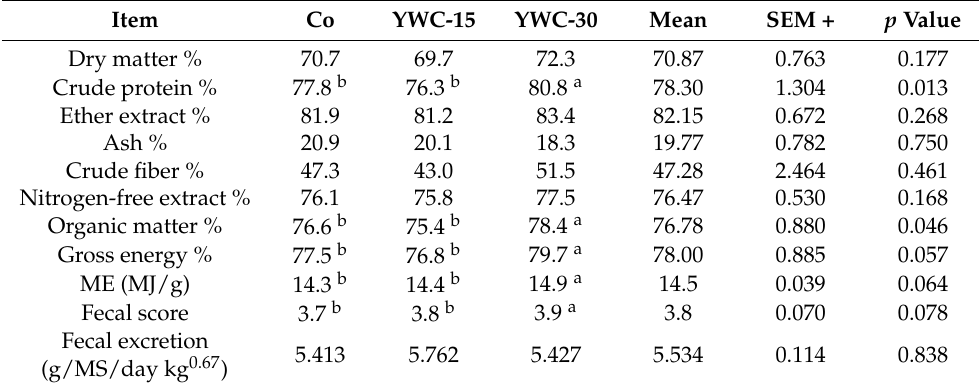
Table 3. Apparent digestibility coefficients, metabolizable energy, and fecal score.